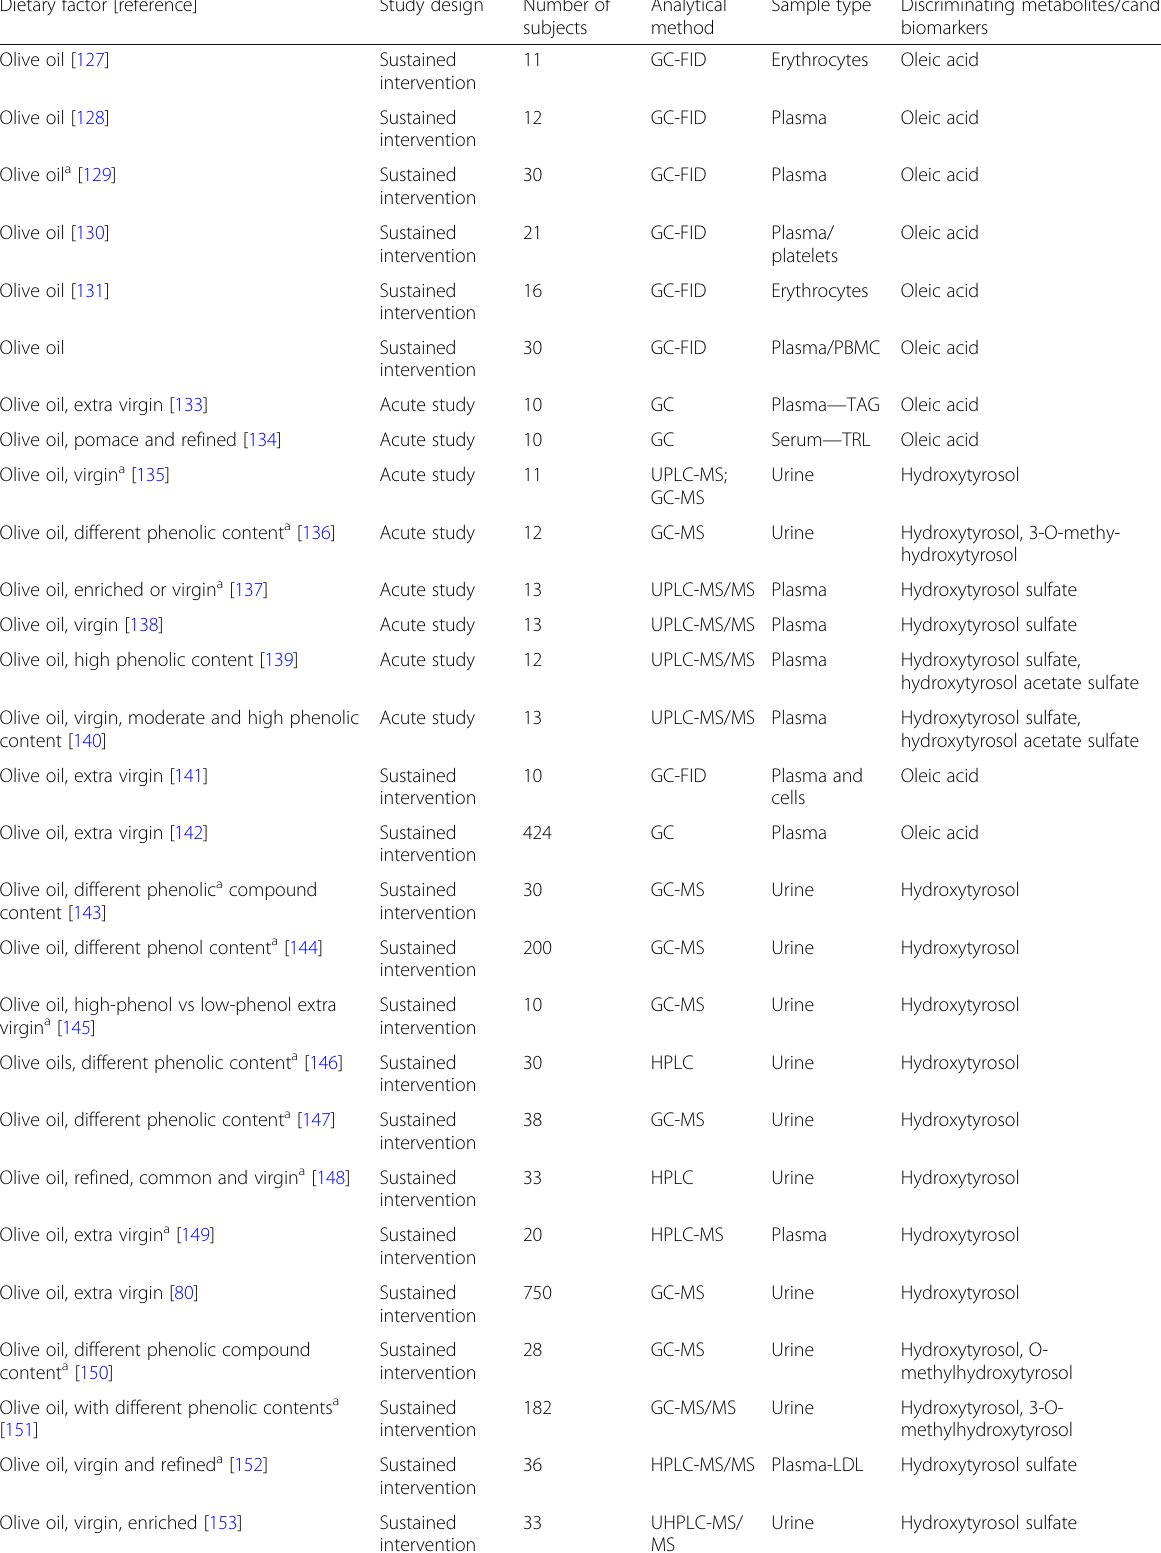
Table 3 Studies reporting associations between consumption and potential candidate food intake biomarkers for vegetable